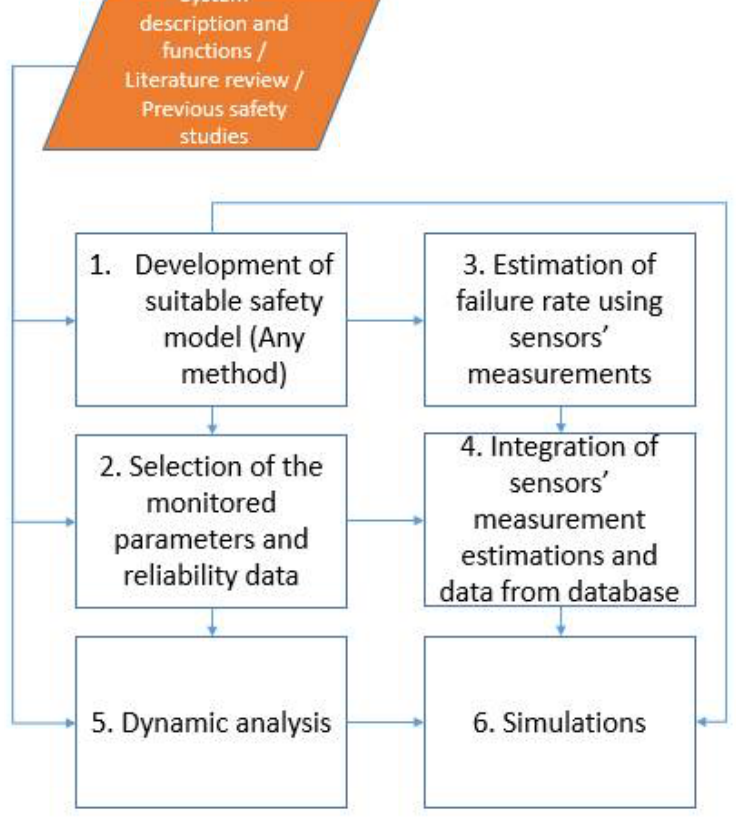
Figure 1. Methodology flowchart for the development and verification of safety monitoring